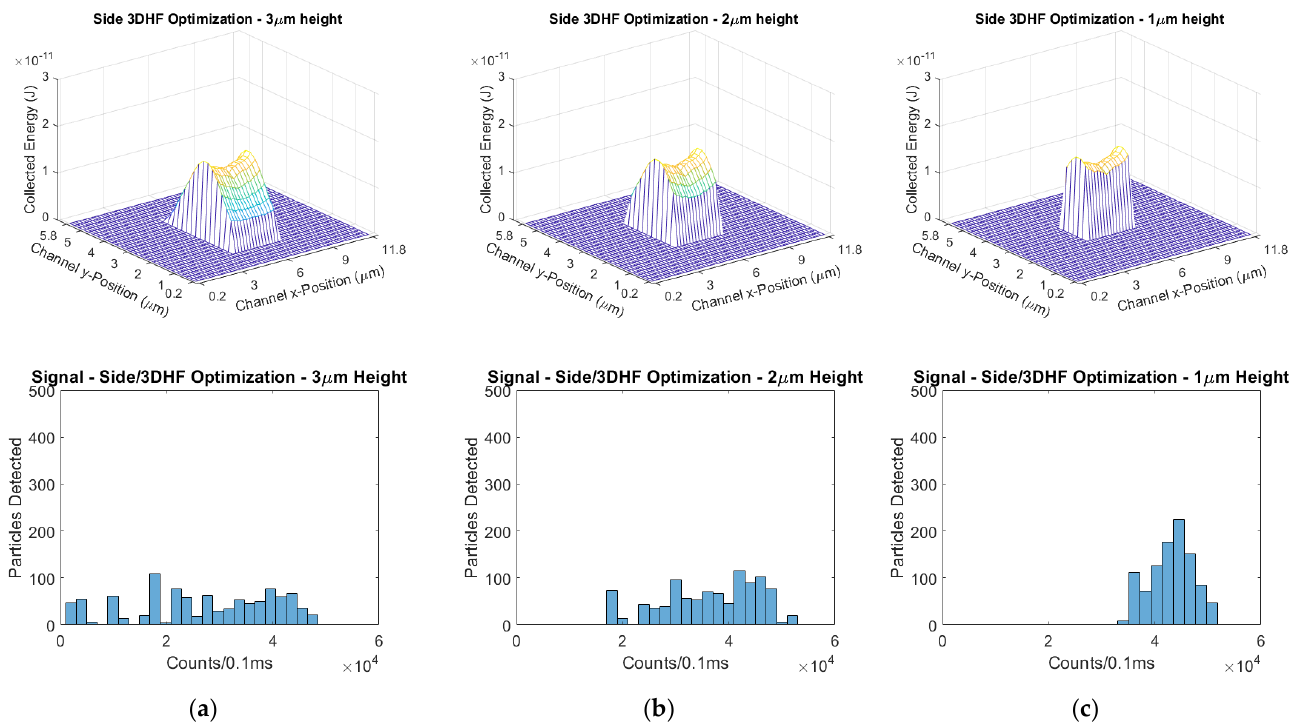
Figure 15. Excitation region profiles and signal distributions of a side/3DHF design with decreasingly focused cross-section height. Compare to the 4 µm height shown in Figure 10a. ( a ) 3 µm height, ( b ) 2 µm height, and ( c ) 1 µm height.